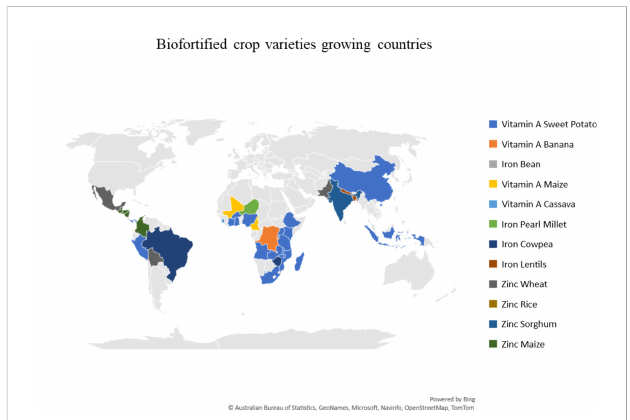
FIGURE 3 Bioforti fi ed crop cultivars grown in The Global South (source: CGIAR